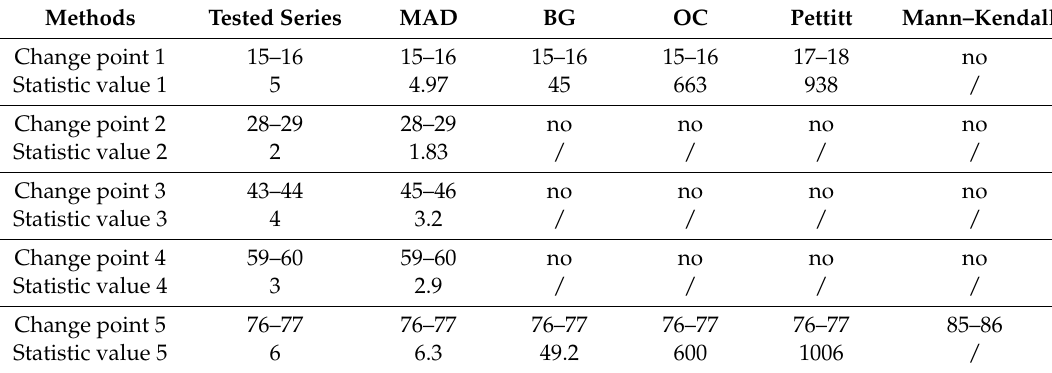
Table 4. Detection results of multi-mutation points series with